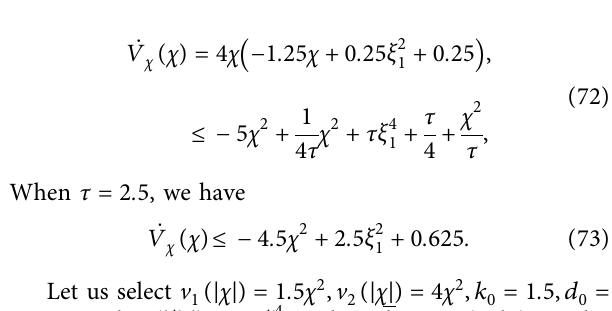
Figure 7: The adaptive parameters 􏽢 θ